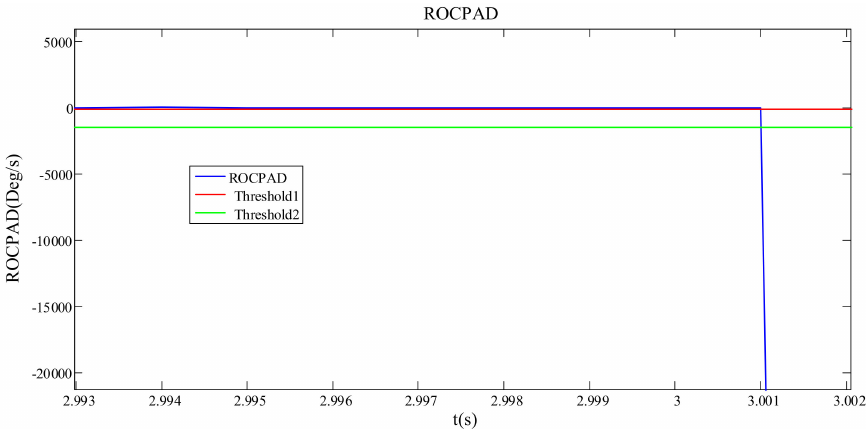
Figure 7. The output of ROCOF relay in islanding mode with high power mismatch.